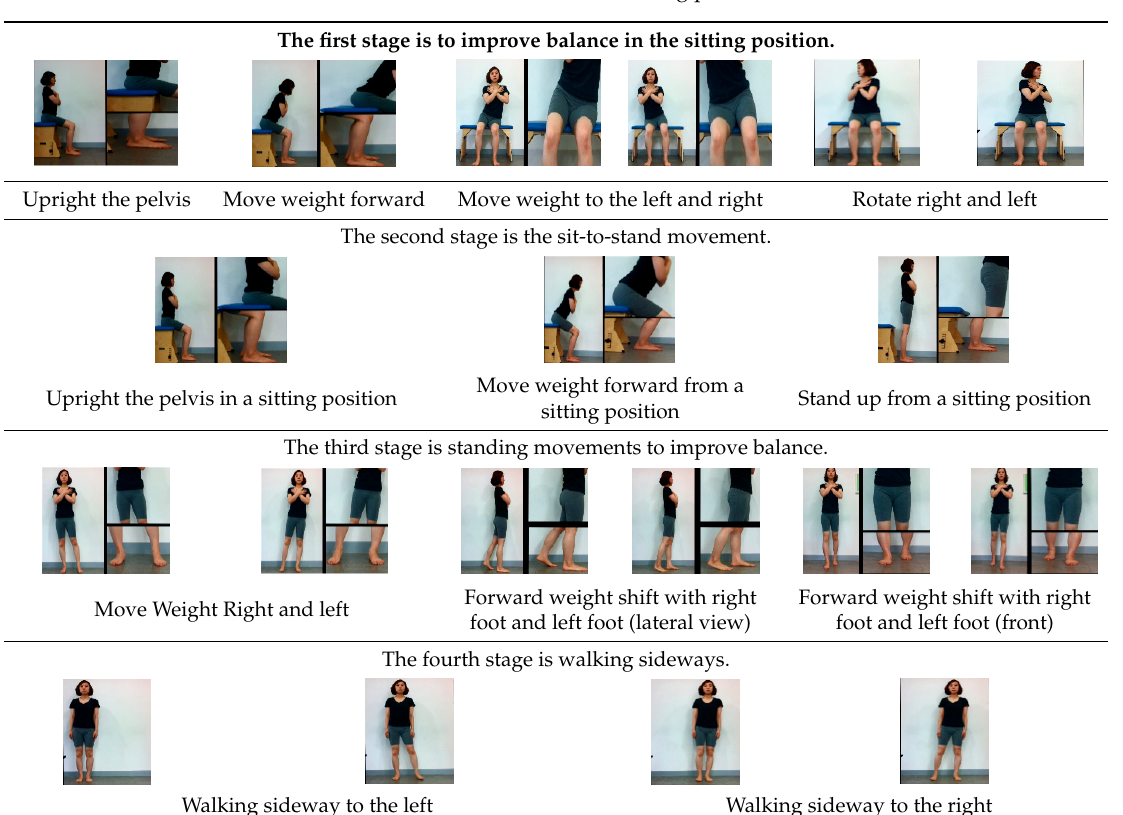
Table 1. Action observation training protocol.